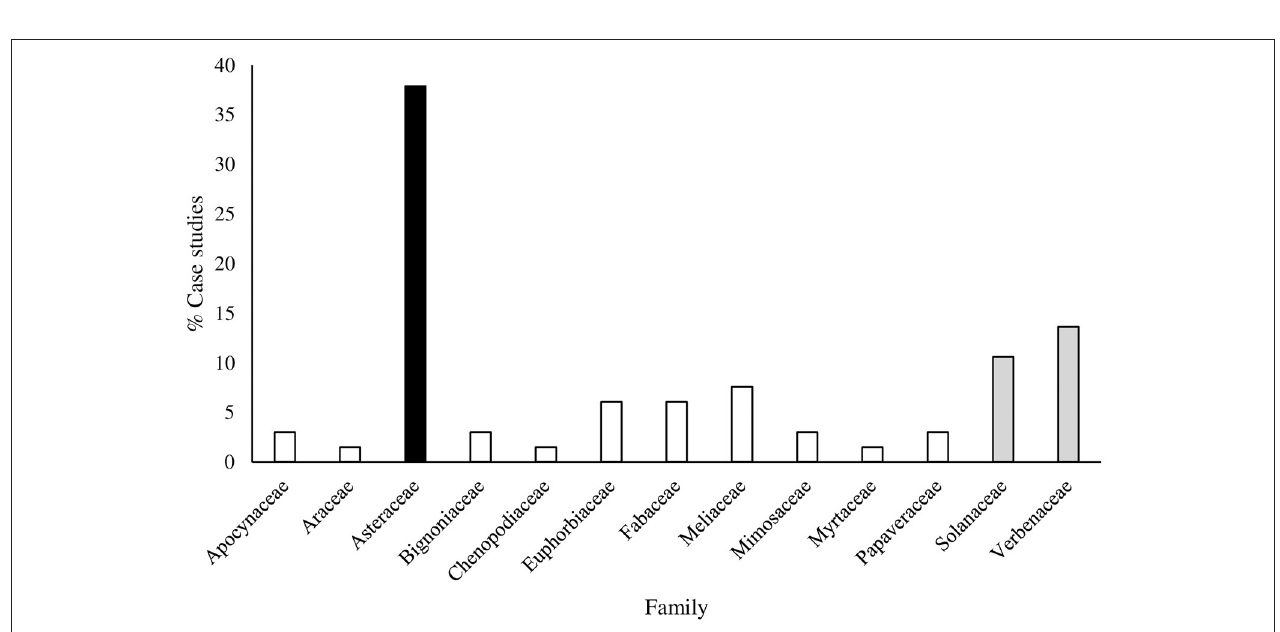
FIGURE 2 | Prevalence of case studies on different families of invasive alien plant species tested for insecticidal activities. Data was obtained from 69 published case studies.